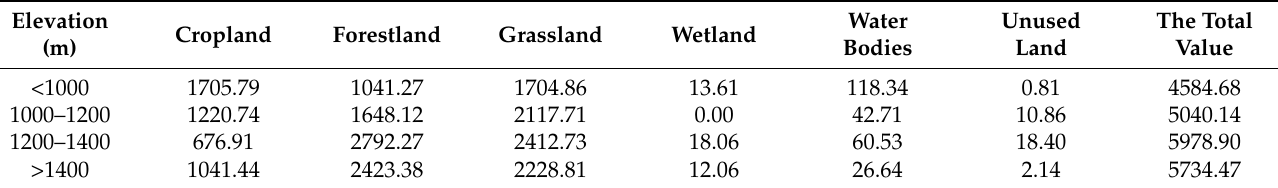
Table 9. ESV per unit area of different elevation levels. Unit: yuan/hm 2 .